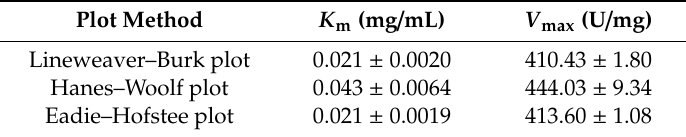
Table 4. Kinetic parameters for PN32 by di ff erent